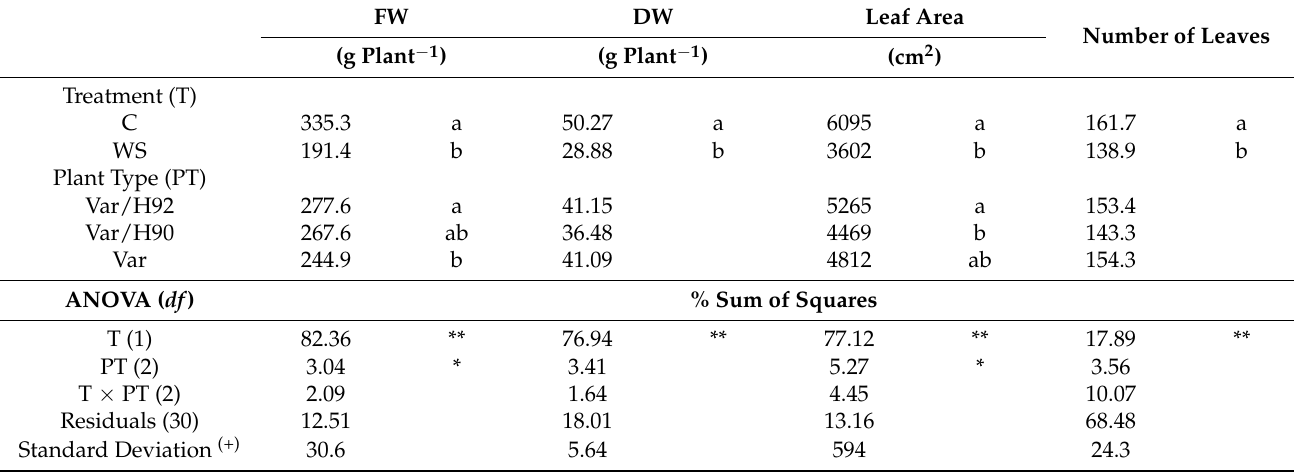
Table 1. Effect of factors treatment (T) and plant type (PT) on the fresh weight (FW) of aerial parts expressed as mean values and